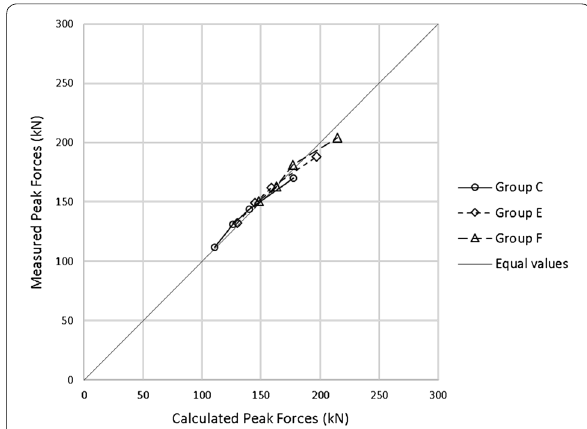
Fig. 9 Comparison between measured and calculated peak vertical